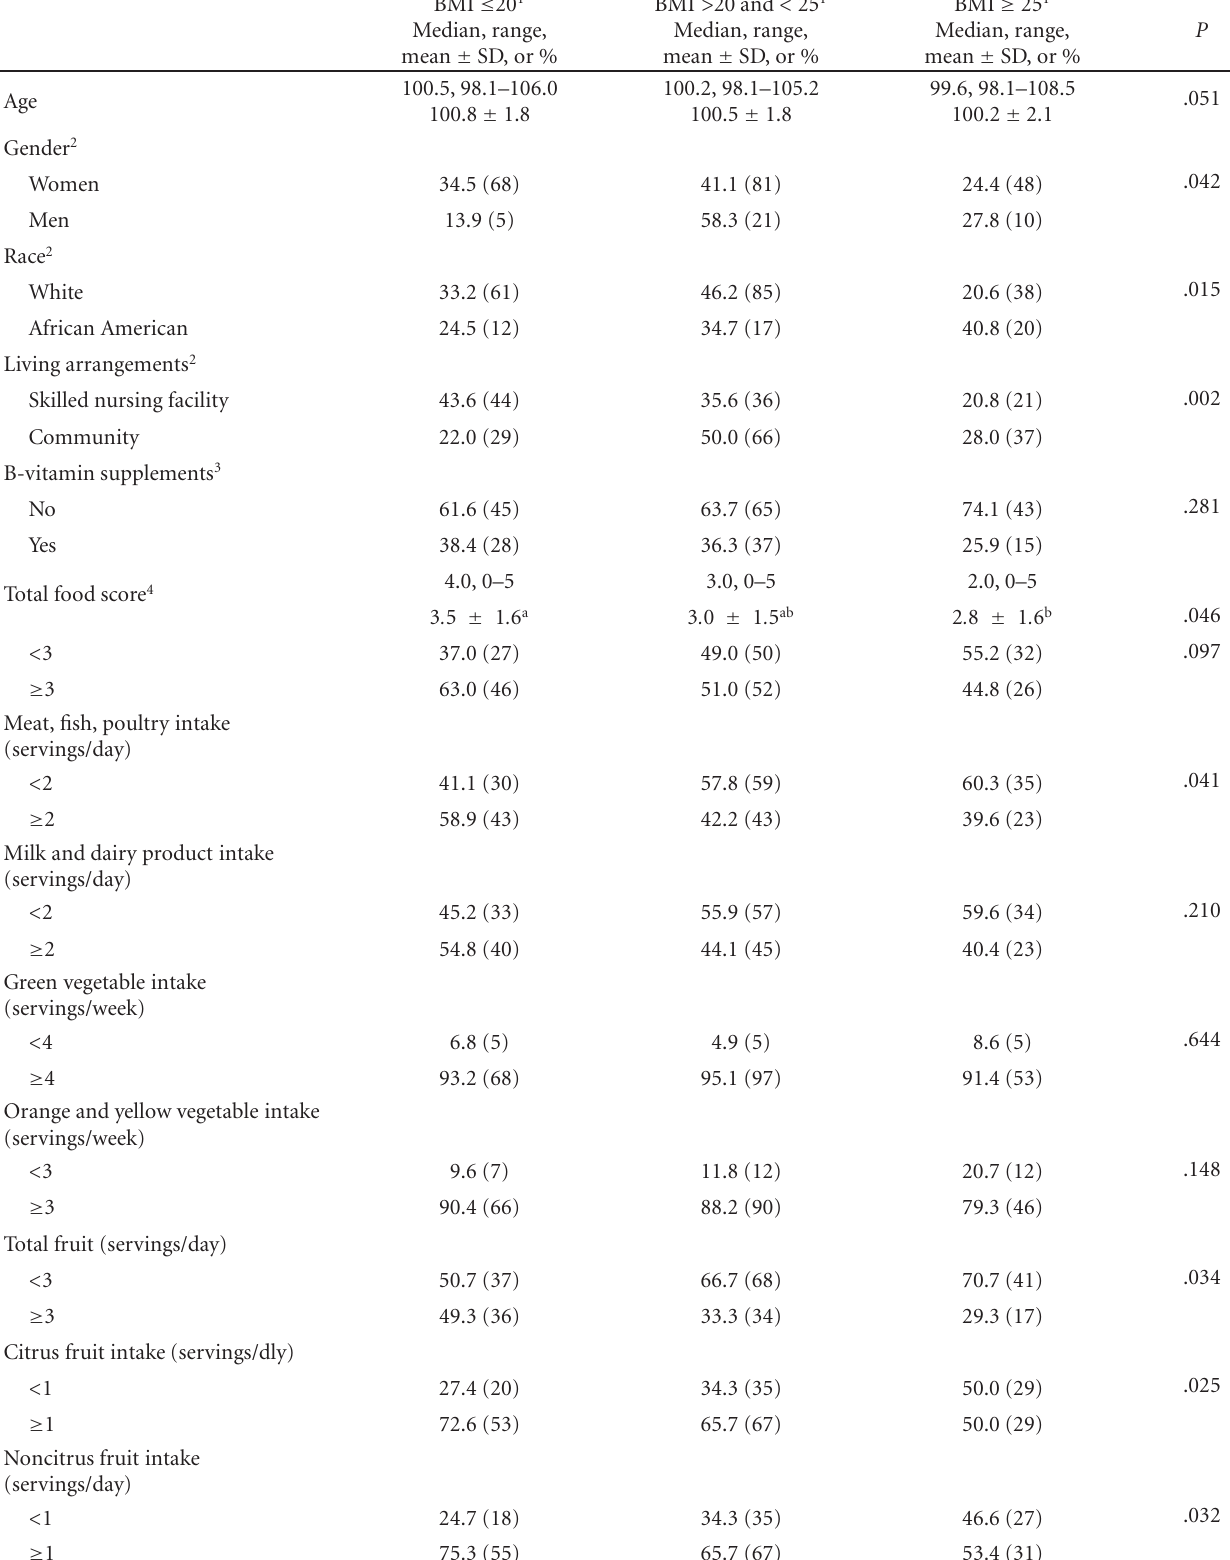
Table 2: Demographics, dietary patterns, and health conditions of centenarians of varying BMI classification: The Georgia Centenarian